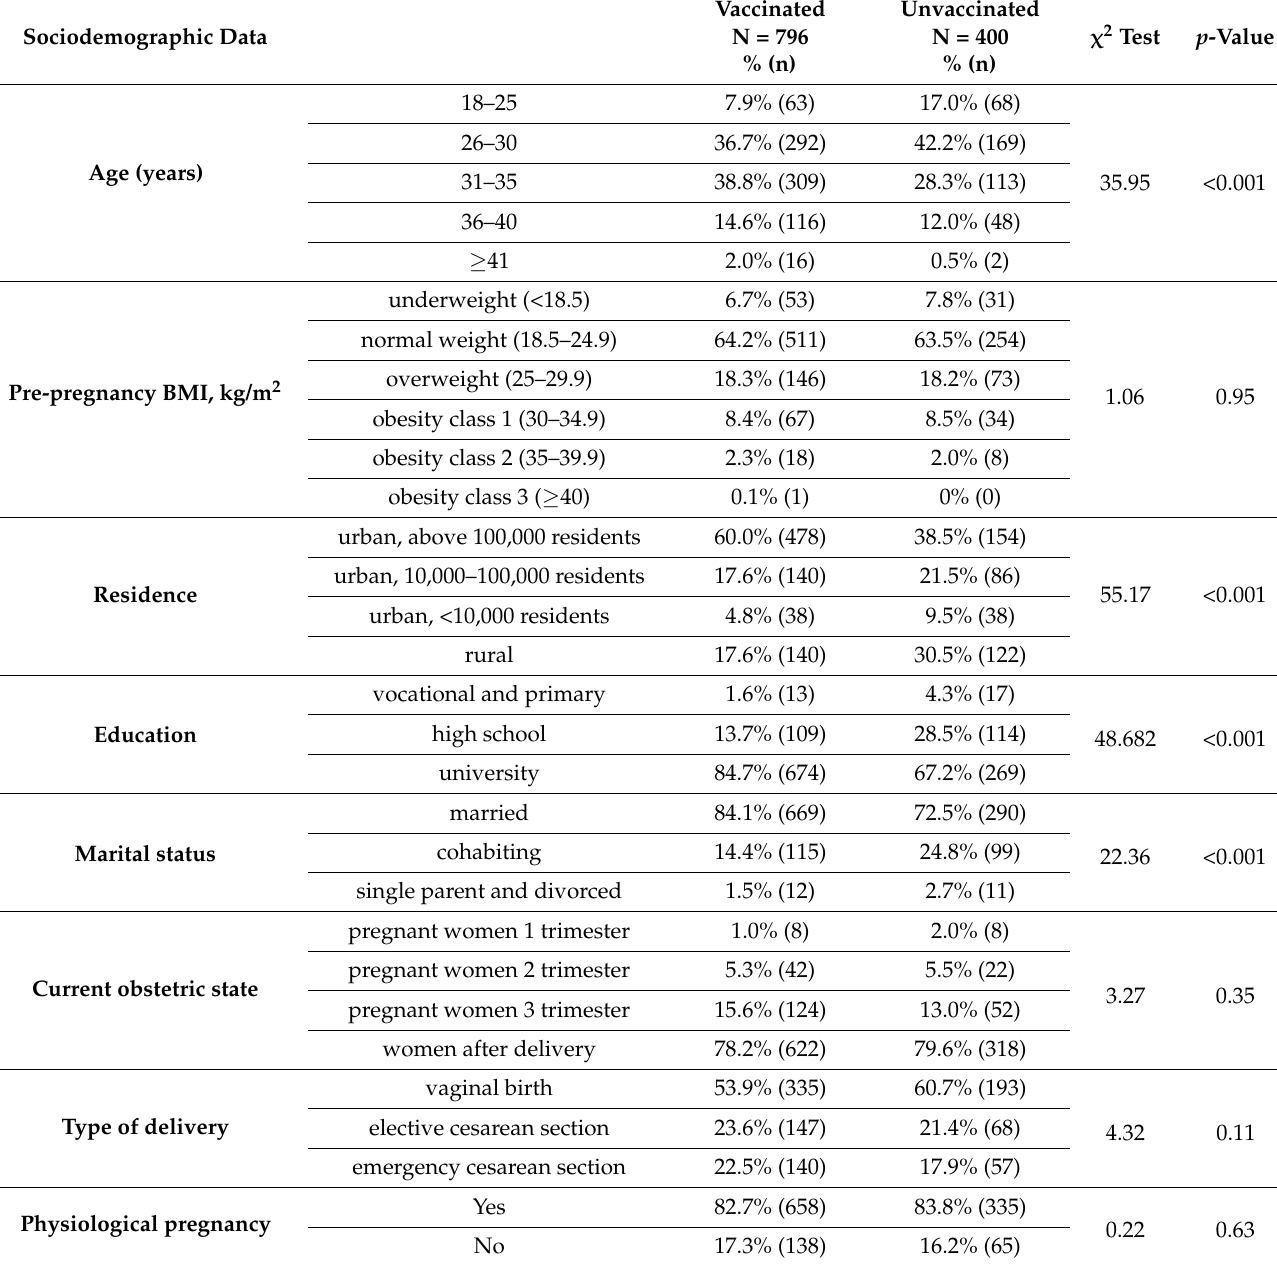
Table 2. Level of COVID-19 vaccination among women in relation to sociodemographic